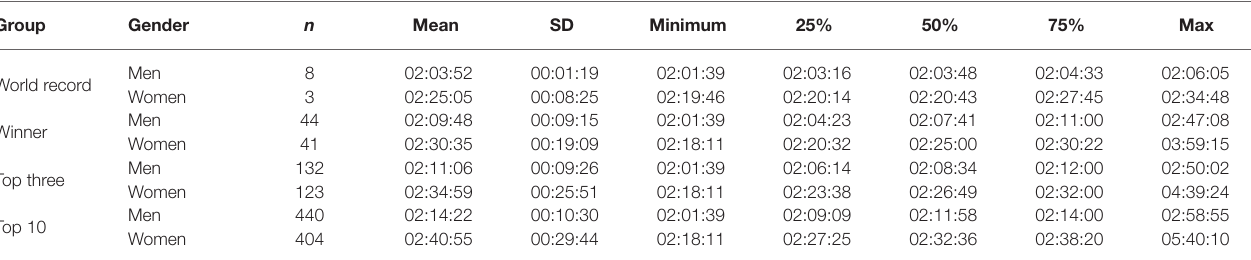
TABLE 2 | Marathon finishing times by performance groups and gender, expressed as mean, SD, 25, 50, 75% quartile and minimums and maximum in h:min:s. Group